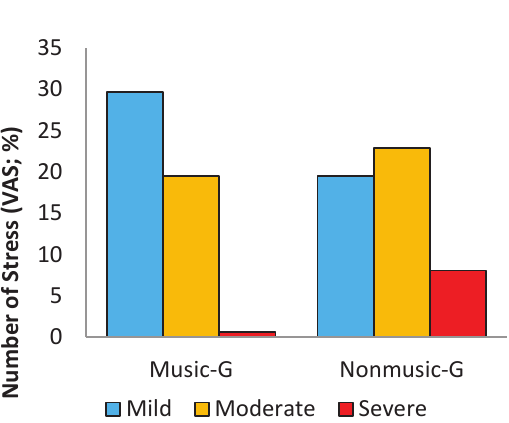
Table.2. Table of cross influence of listening to classical music on stress alleviation in students while